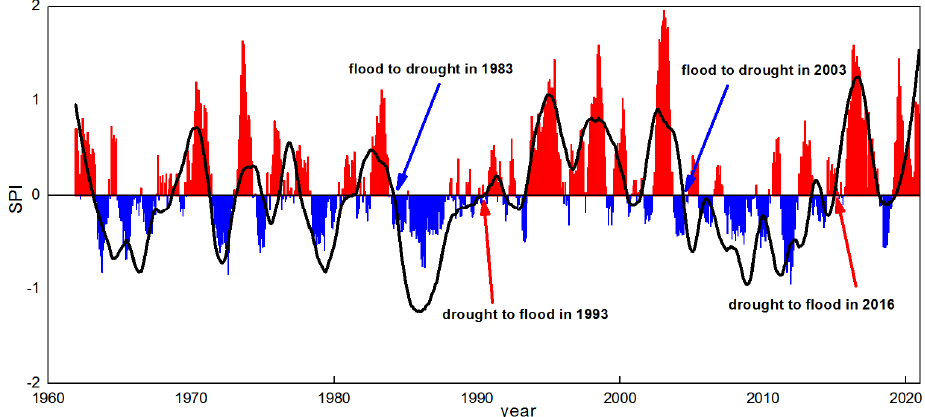
Figure 2. Temporal variation of the SPI sequence over the Dongting Lake basin in recent 60 years. The bar represents the SPI value (red bar indicates positive SPI and blue bar indicates negative SPI), and the black curve represents the trend extracted from 51month moving average.